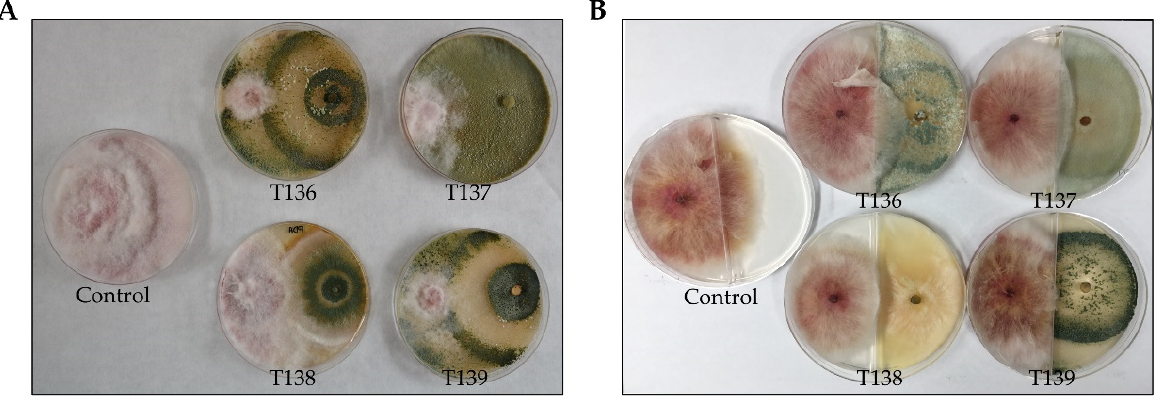
Figure 2. Dual cultures of four Trichoderma strains ( T. harzianum T136, T. simmonsii T137, T. afroharzianum T138, and T. harzianum T139) (on the right of each plate) and the pathogen Fusarium graminearum (on the left). ( A ) Using 8.5 cm Petri plates, and ( B ) using centrally partitioned 8.5 cm Petri plates. Control corresponds to the pathogen growing alone. The plates were incubated at 28 °C for four days.